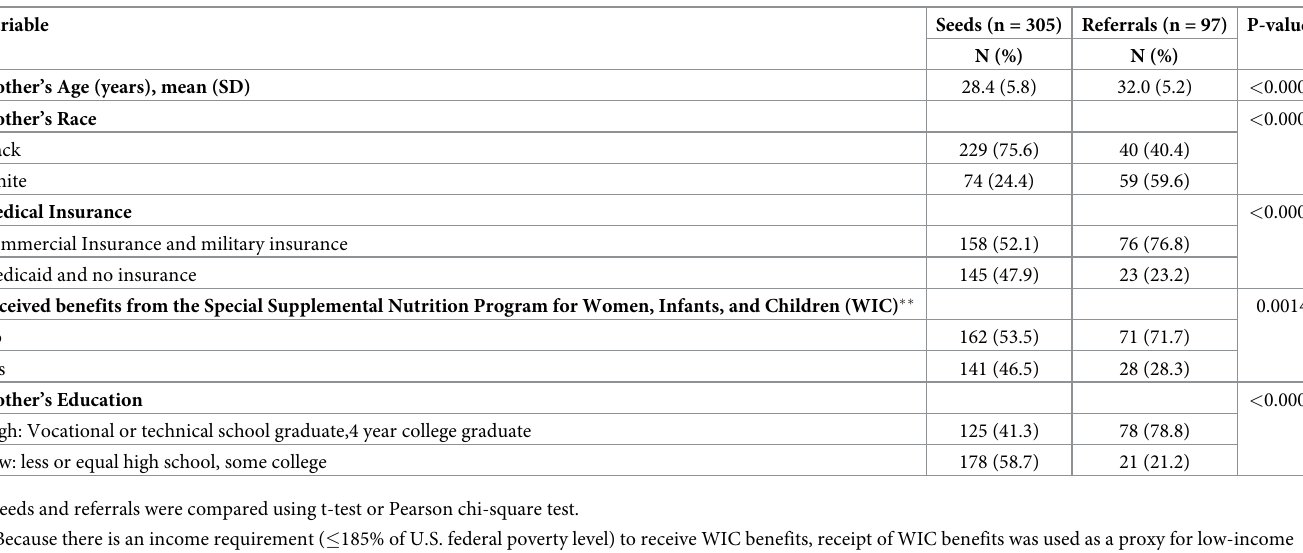
Table 1. Sociodemographic characteristics of the sample by RDS